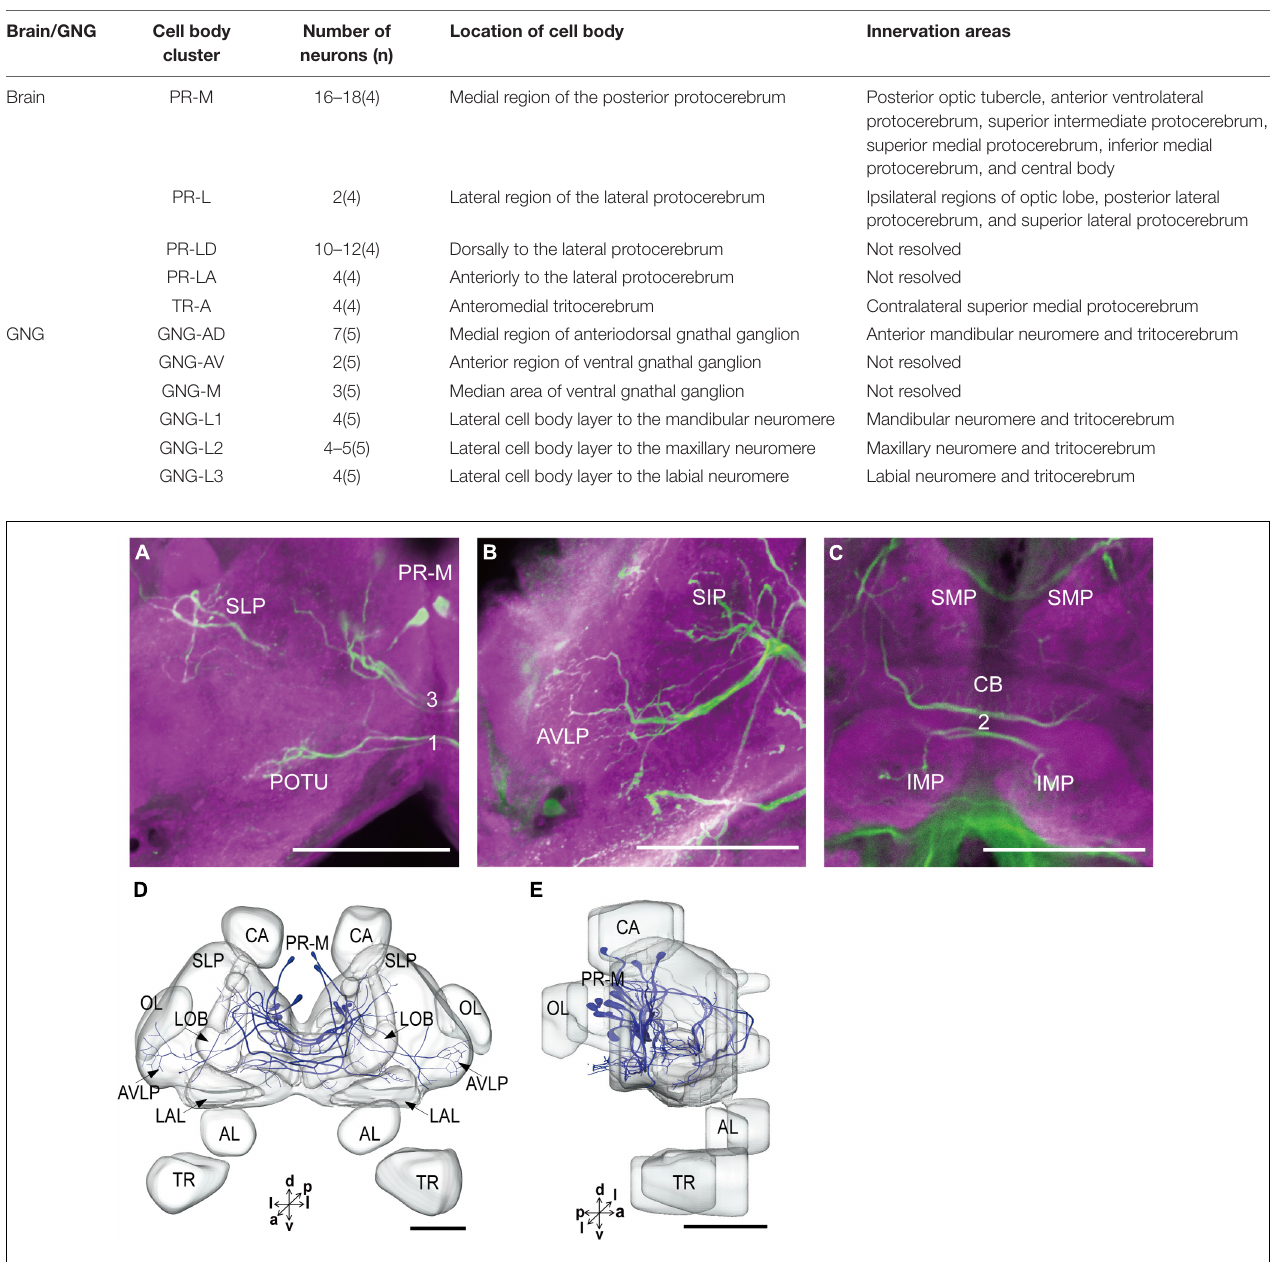
FIGURE 3 | The projection area of PR-M neurons. (A–C) The confocal stack images of PR-M neurons. (D) The anterior view of three-dimensional reconstructions of PR-M neurons. (E) The lateral view of three-dimensional reconstructions of PR-M neurons. AVLP, anterior ventrolateral protocerebrum; CB, central body; IMP,